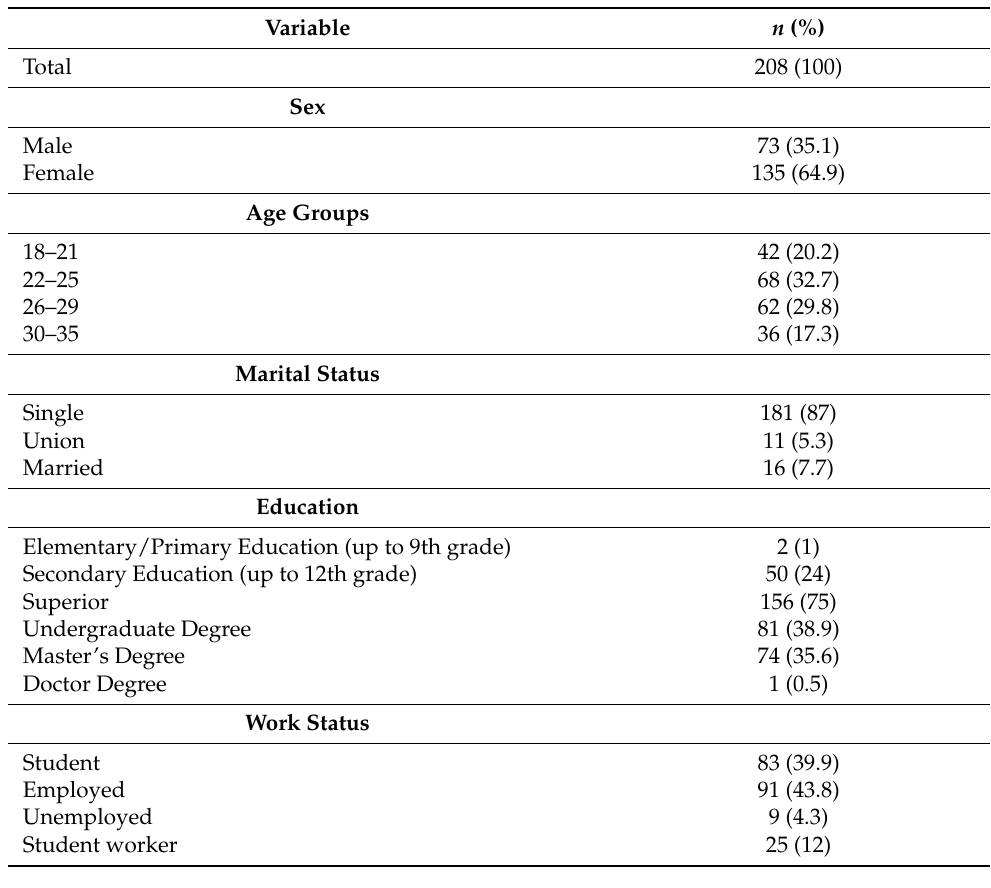
Table 1. Subjects’ sociodemographic